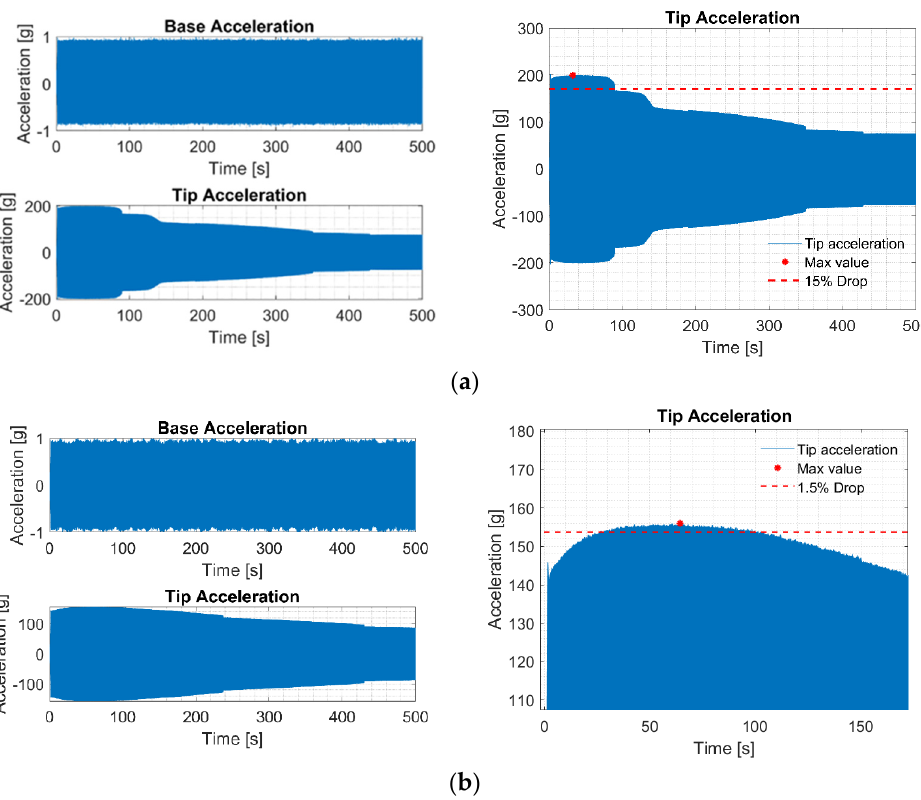
Figure 6. Accelerations measured in correspondence of the base and tip during the endurance tests. ( a ) FCC specimen number 7 and ( b ) Diamond specimen 4.